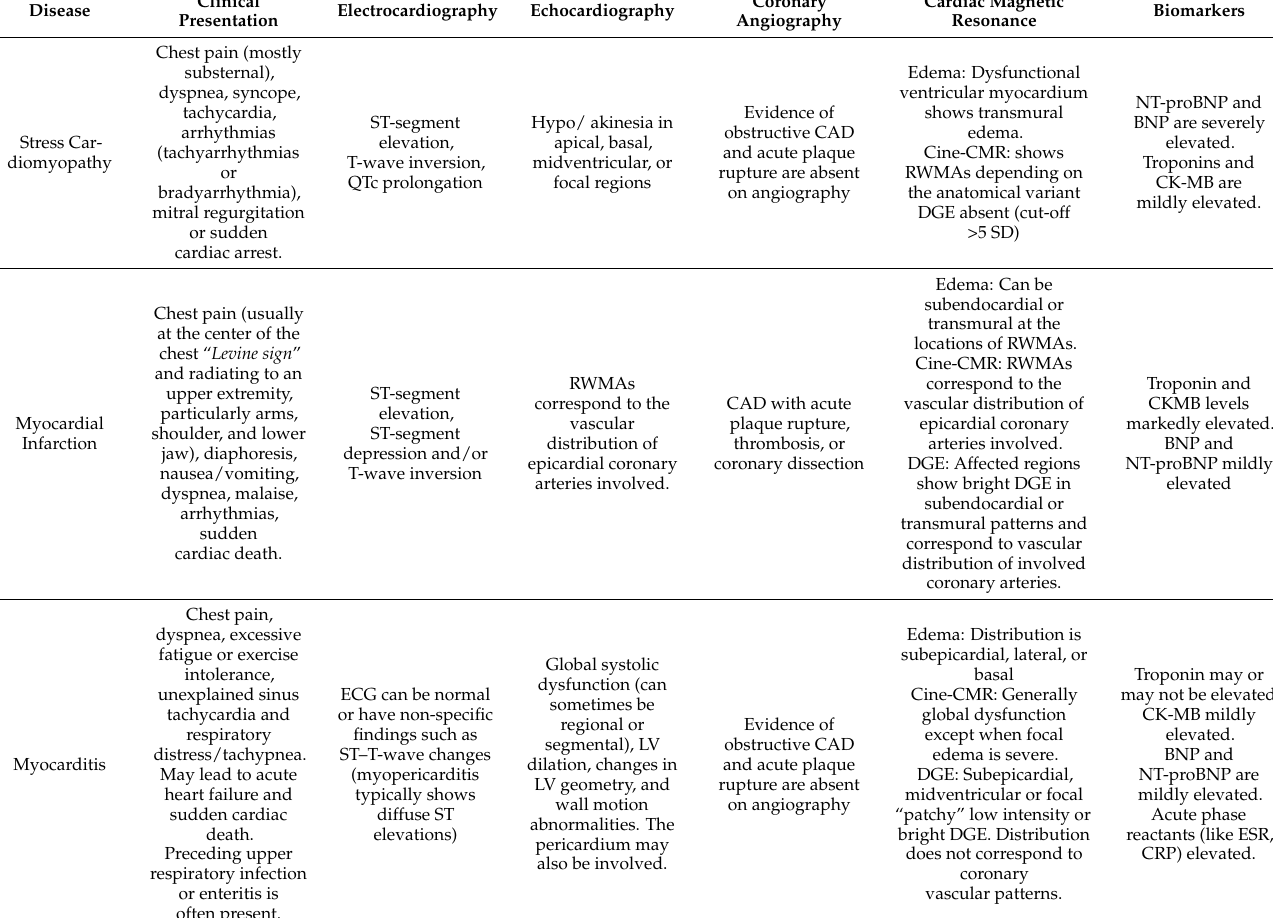
Table 1. Differential Diagnosis of Broken Heart Syndrome and their clinical presentation.